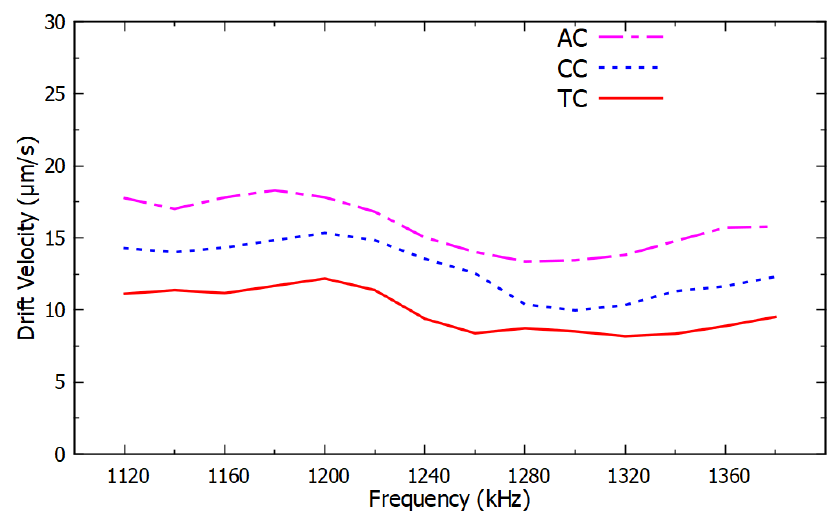
Figure 7. High resolution negative DEP spectra from 1120 kHz to 1380 kHz for the same ssDNA sequences used in Figure 6.